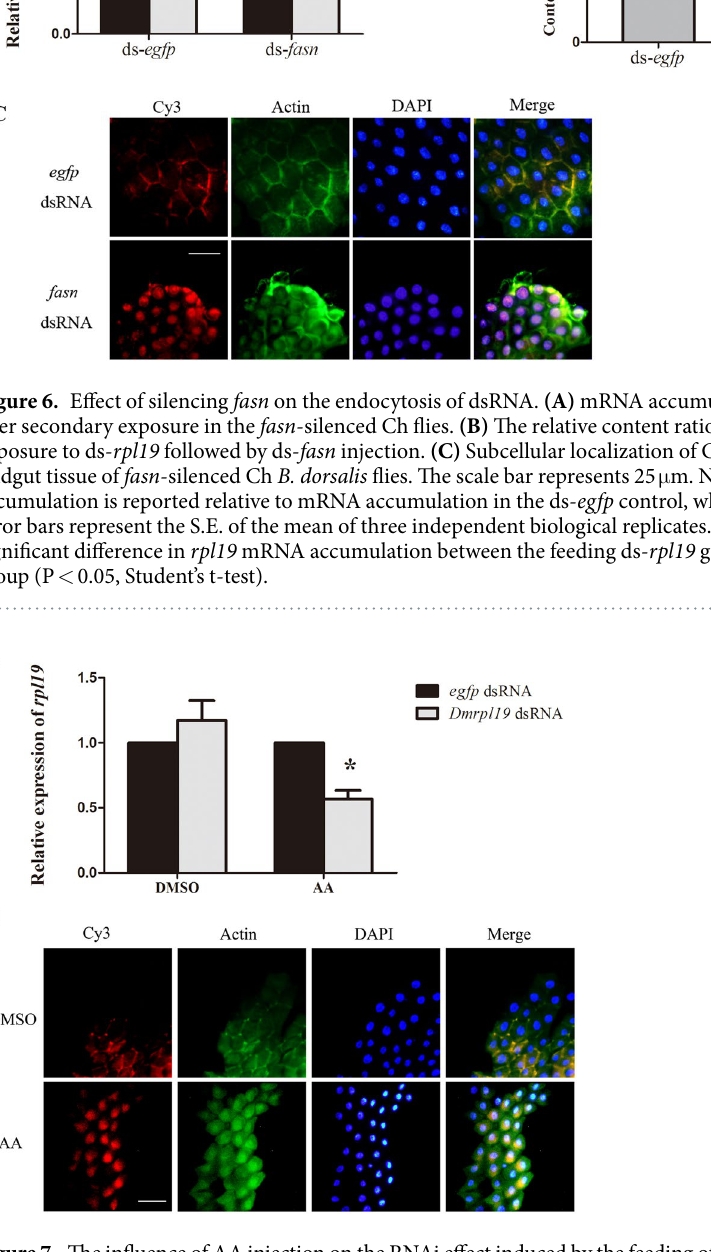
Figure 7. The influence of AA injection on the RNAi effect induced by the feeding of dsRNA in D. melanogaster . (A) mRNA accumulation of the target gene after feeding ds- Dmrpl19 followed by injecting AA. ( B ) Subcellular localization of Cy3-labelled ds- Dmrpl19 in midgut tissue of D . melanogaster after the injection of AA. The scale bar represents 25 μ m. Normalized target gene mRNA accumulation is reported relative to mRNA accumulation in the ds- egfp control, which was set to 1. All error bars represent the S.E. of the mean of three independent biological replicates. * indicates a statistically significant difference in rpl19 mRNA accumulation between the feeding ds- rpl19 group and the control ds- egfp group (P < 0.05, Student’s